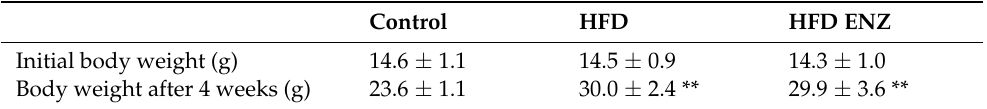
Table 1. Body weight in experimental period.